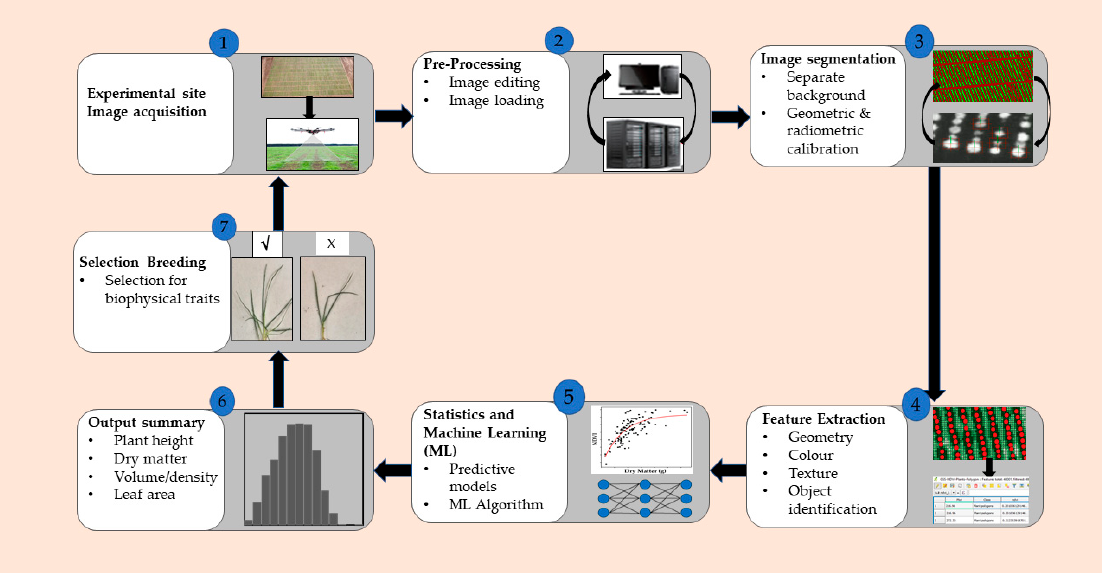
Figure 4. A diagram of workflow indicating image acquisition, processing and analysis. Image- and data-processing platform (in phenomics lab) requires data and image capture from an experimental field. Images and data obtained can be preprocessed to remove noise and artefacts and stored in a server for further processing. Images can be further identified, segmented and classified from the background and nontarget objects using the software. In the post-megadata processing, machine learning through predictive models would develop to the framework for data analysis and analysed data can be used to rank, visualise and screen at individual, row and sward plot levels.